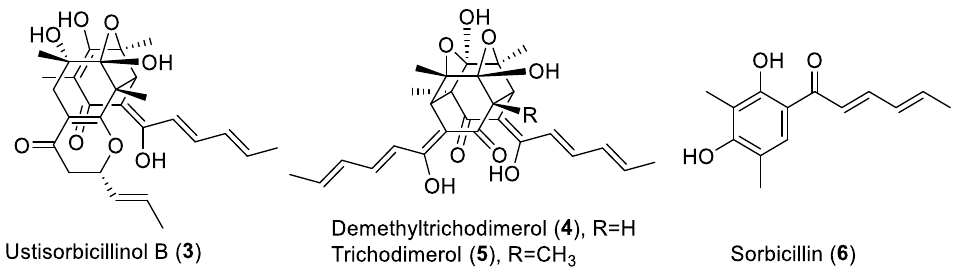
Figure 4. Colony morphologies and HPLC profiles of sorbicillinoids from WT strain, deletion mutants and complemented strains of U. virens. ( A ) HPLC profiles of the WT strain, ∆ UvSorA mutant and ∆ UvSorA C strain detected with UV at 370 nm (left panel). Colony morphologies (back view) observed after 28 days of culture on the PDA plates (right panel); ( B ) HPLC profiles of the WT strain, ∆ UvSorB mutant and ∆ UvSorB C strain detected with UV at 370 nm (left panel). Colony morphologies (back view) observed after 28 days of culture on the PDA plates (right panel); ( C ) Chemical structures of sorbicillinoids ( 1 )–( 6 ).